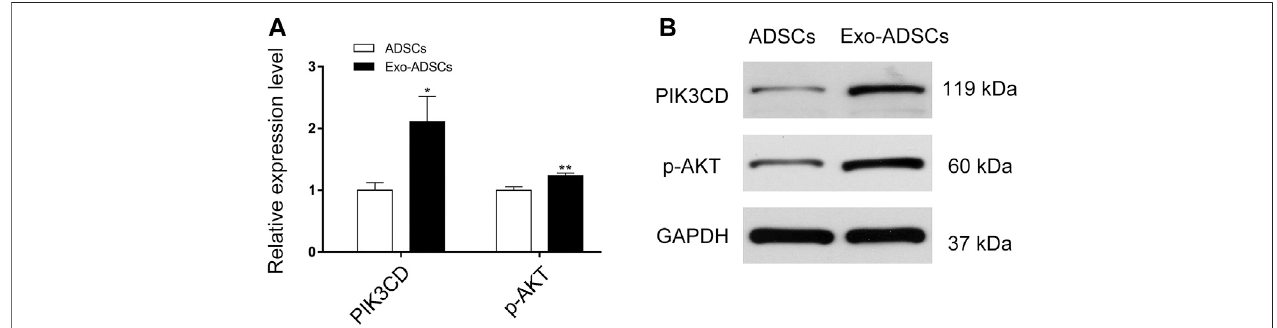
FIGURE7| ValidationofthePI3K-Aktsignalingpathway. (A) RT-qPCRanalysisofPIK3CDandAktmRNAexpressioninADSCsandExo-ADSCs. (B) Westernblot analysis of the protein levels of PIK3CD and phosphorylated Akt (p-Akt) in ADSCs and Exo-ADSCs. The data was presented as the mean ± SD ( n (cid:1) 3 independent experiments). * p < 0.05, ** p <